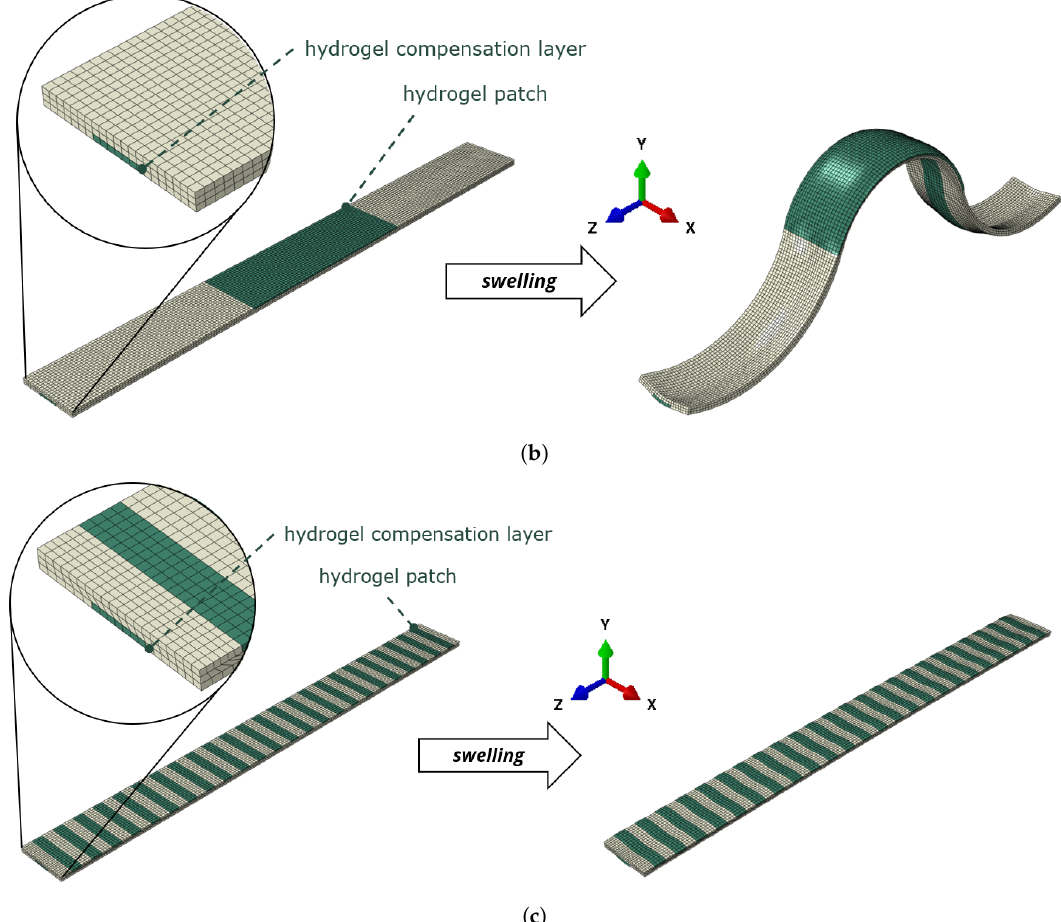
Figure 8. Two-dimensional swelling active–passive composite structure showing the goal for the cross-section of the plate. For all structures, the width in x -direction is 100mm, the height in y -direction is 10mm and length in z -direction is 1000mm. The dimensions of the hydrogel-patches vary according to Table 1. Please note that due to different volumes of active material, the temperatures for the swollen states also vary. ( a ) Two-layer structure with active top layer and passive bottom layer. The temperature of the deformed state is ϑ = 32.1 ◦ C. The results were obtained with Abaqus according to Section 2 with 24000 linear hexahedral elements of type C3D8R. ( b ) In addition to the compensation strip on the bottom side, one patch is inserted. The temperature of the swollen state is ϑ = 33 ◦ C. The results were obtained with Abaqus according to Section 2 with 14652 quadratic hexahedral elements of type C3D20R. ( c ) In addition to the compensation strip on the bottom side, 24 patches are inserted. The temperature of the swollen state is ϑ = 33 ◦ C. The results were obtained with Abaqus according to Section 2 with 11880 quadratic hexahedral elements of type